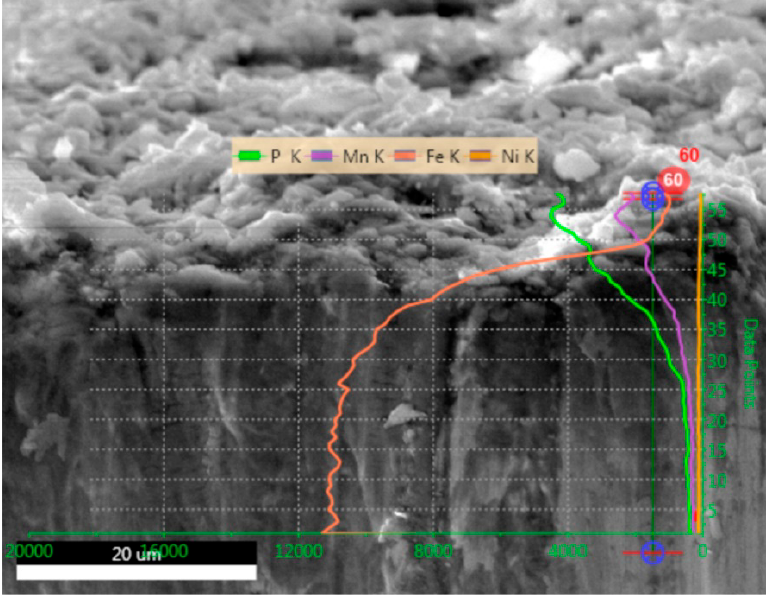
Figure 5. Cross ‐ section analysis of sample B. Figure 5. Cross-section analysis of sample